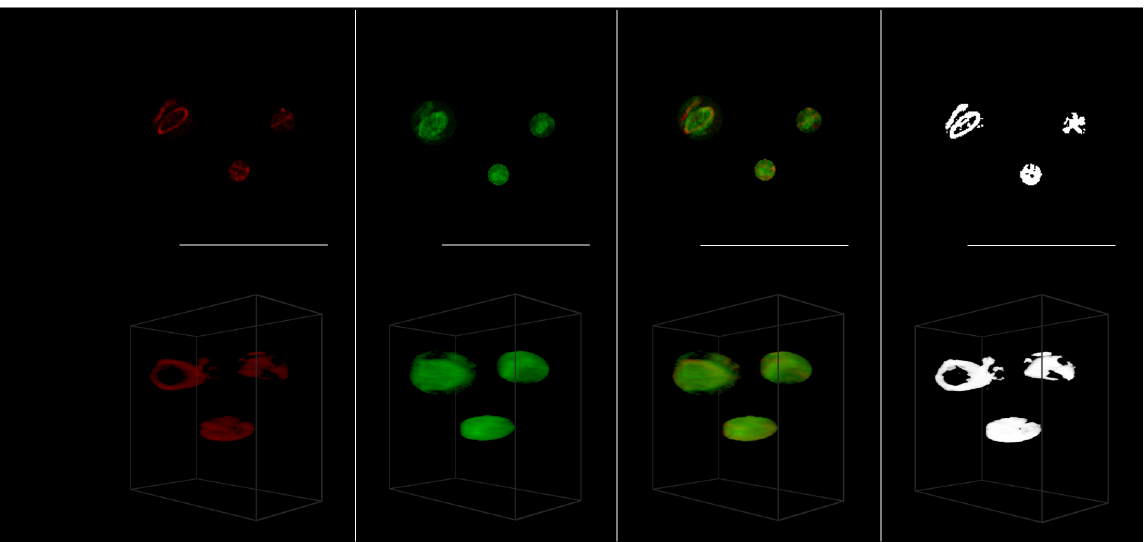
Fig 7. Protein aggregates. Representative cell for t = 6 with the maximum intensity projection at the top and the 45˚ 3D view with the ROI isolated from the whole cell at the bottom. Shown from left to right the acetylated α -tubulin (red), the Tau (green), the tubulin and Tau overlaid, and only the colocalized pixels/voxels. For the protein aggregates only the results at t = 6 were visualized and analyzed.